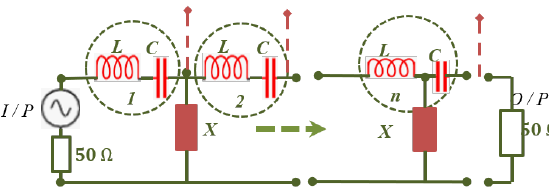
Fig. 2. The basic tunable bandpass-filter of n th coupled resonator in parallel structure with a coupling reactance X